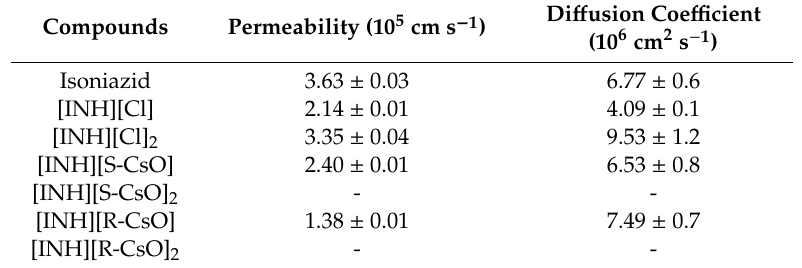
Figure 2. Solubility of isoniazid and organic salts prepared with isoniazid in water and PBS, the results are represented as mean ± standard deviation. Table 3. Permeability of isoniazid and organic salts through synthetic membranes at 37 °C in PBS.